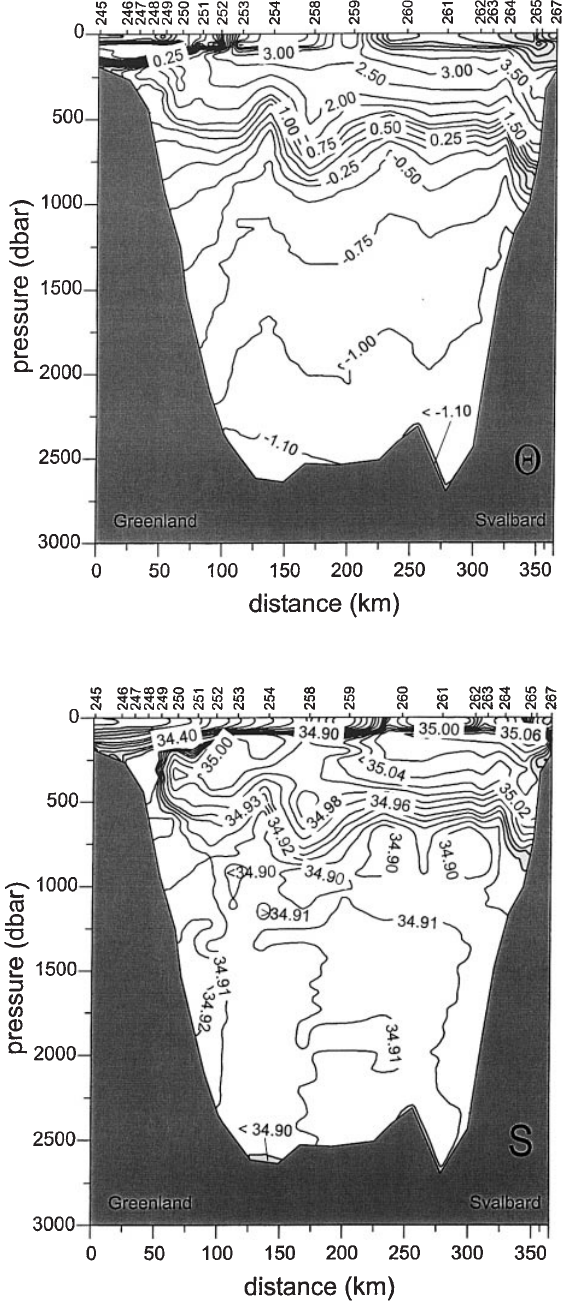
Fig. 16. The distribution of potential temperature and salinity on a section taken across Fram Strait along 78 (cid:176) 55 ¢ N by RV Lance in